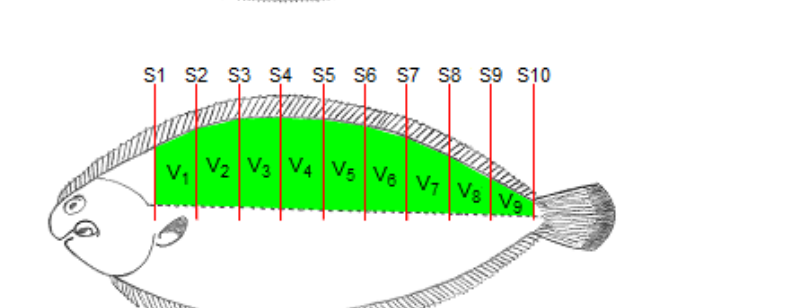
Table 1. Mean, standard deviation (sd), minimum, maximum and coefficient of variation (CV) for fish and real-time ultrasonic (RTU) traits (n =